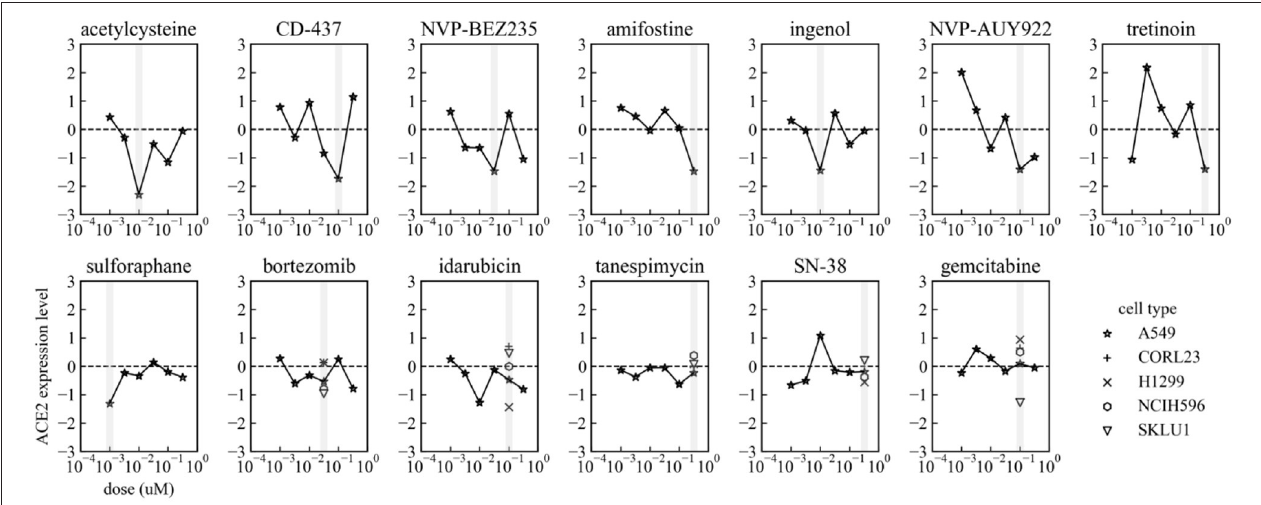
FIGURE 2 | Dose-response of ACE2 expression levels in each small molecule in A549. Gray vertical bars mean the optimal dosages in each small molecule indicated in Table 1 . ACE2 expression levels in CORL23, H1299, NCIH596, and SKLU1 are also shown in Bortezomib, Idarubicin, Tanespimycin, SN-38, and Gemcitabine.